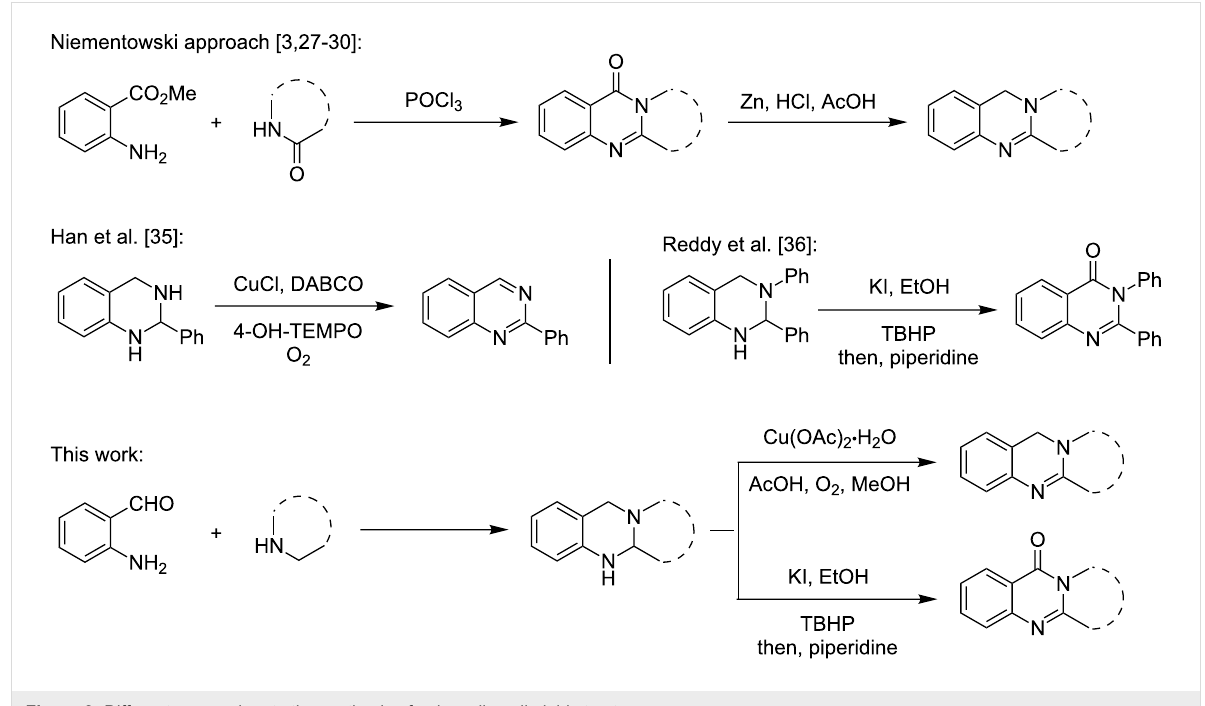
Figure 2: Different approaches to the synthesis of quinazoline alkaloid structures.